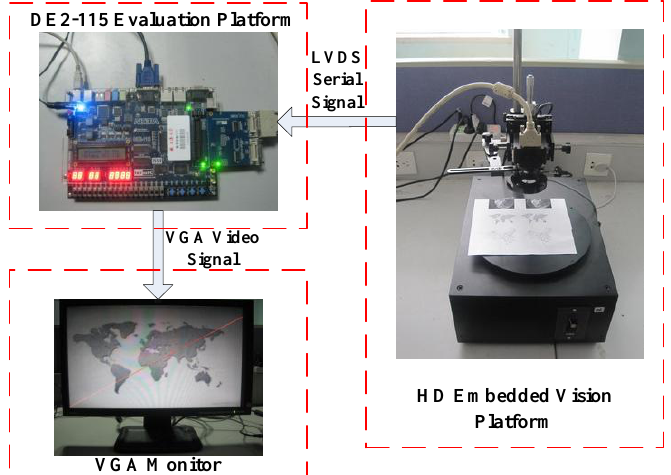
Figure 13. FPGA based embedded straight line detection vision